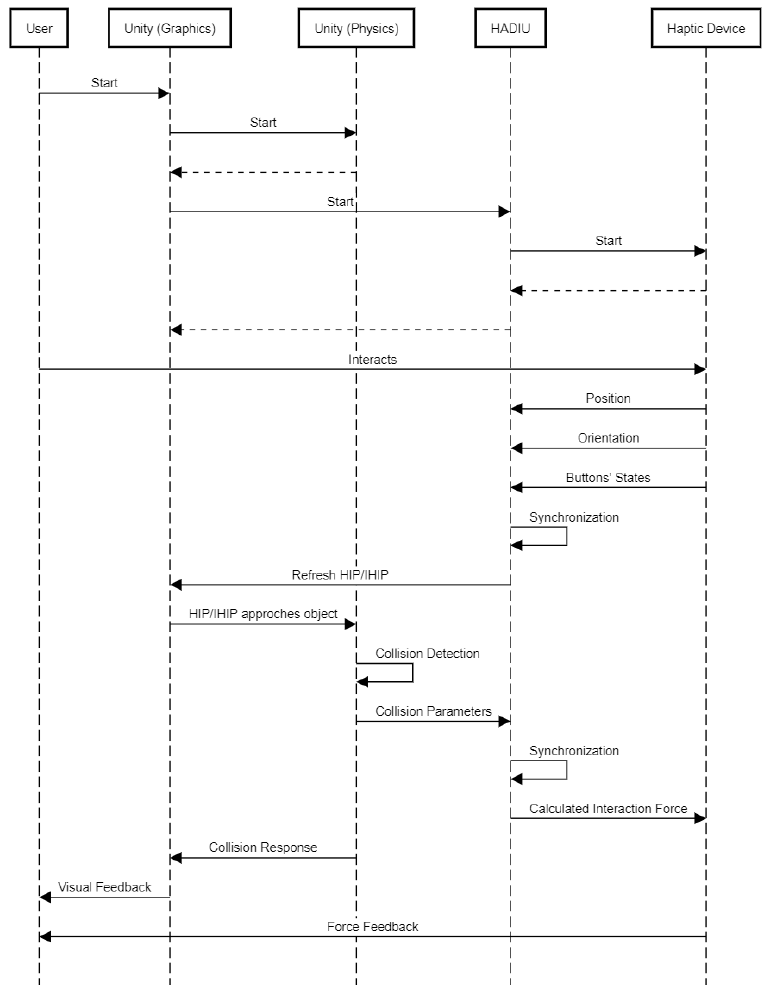
Figure 7. HaDIU’s sequence diagram that describes how all the proposed architecture’s components collaborate during the communication with haptic devices and calculation of feedback force according to their interactions with virtual